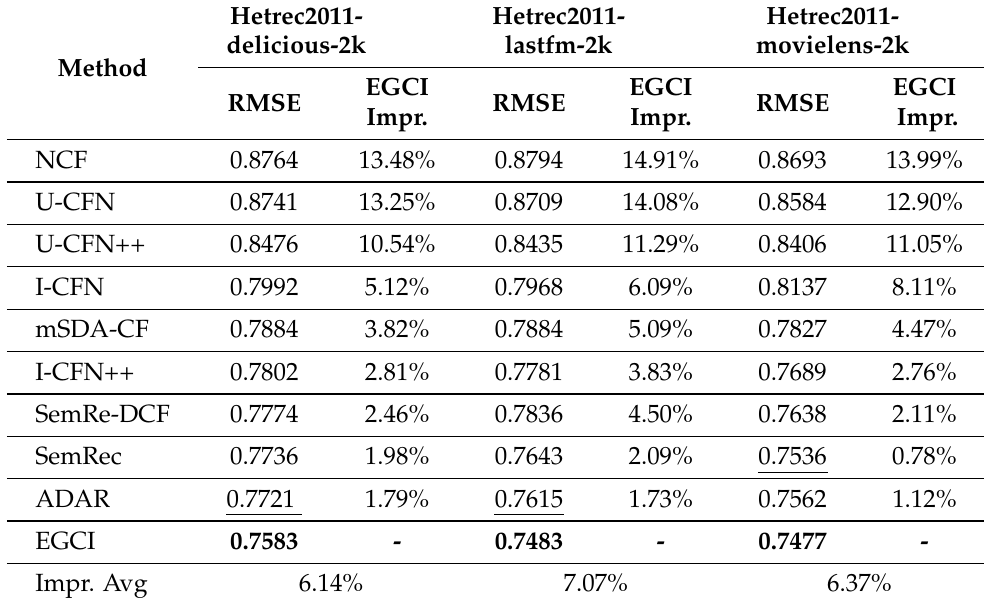
Table 4. Overall comparison of